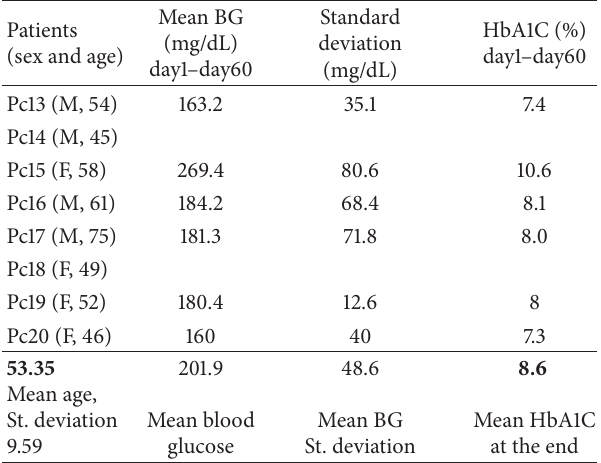
Table 3: Evaluation of the impact of the use of Mobil Diab on the clinical results: intervention group versus control group.